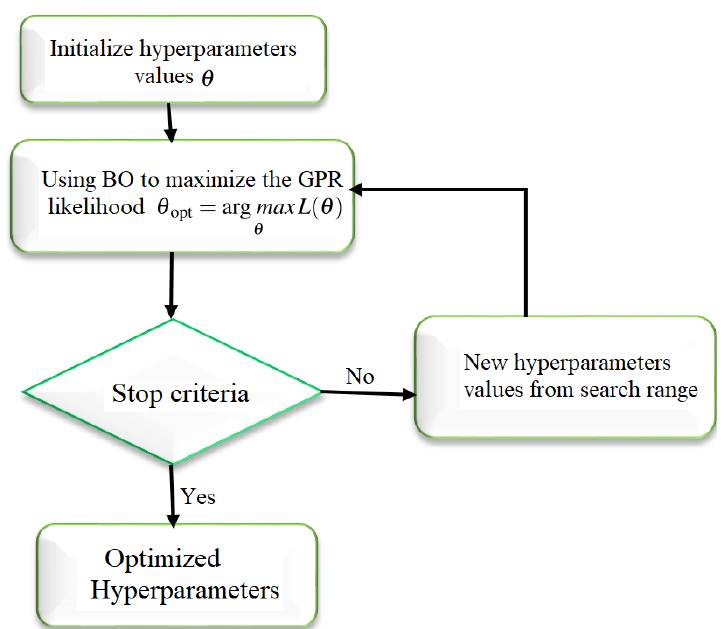
Figure 1. BO-based optimized GPR